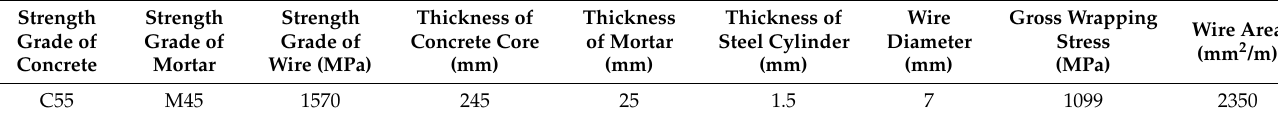
Table 1. Geometry and design parameters for test PCCP.